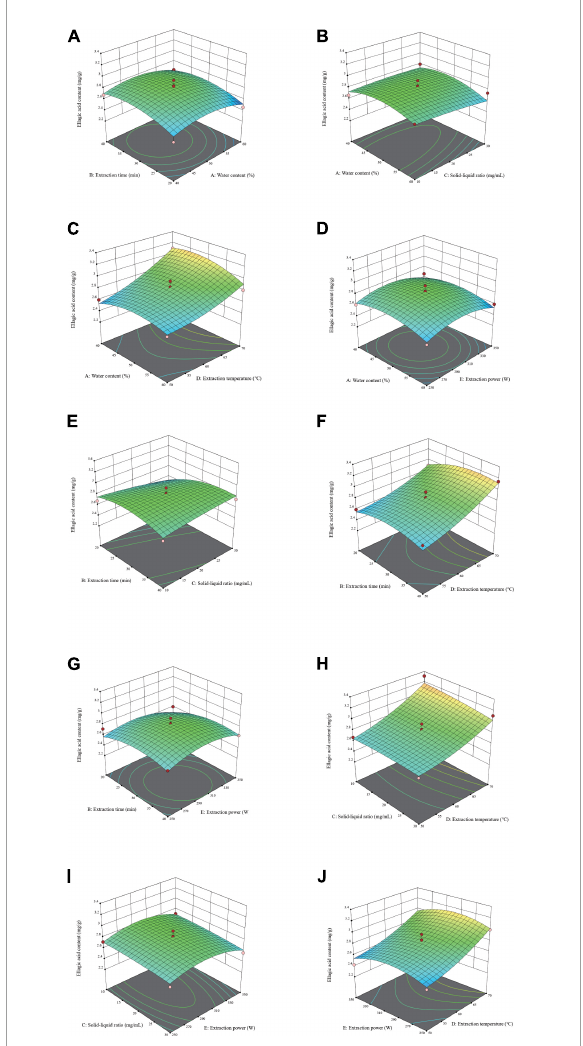
FIGURE3 Three-dimensional response surface diagrams of water content of natural deep eutectic solvents (NADES) (X 1 ), extraction time (X 2 ), solid-liquid ratio (X 3 ), extraction temperature (X 4 ), and extraction power (X 5 ) show the comprehensive effects of experimental factors on extraction yield of ellagic acid (EA). (A) :